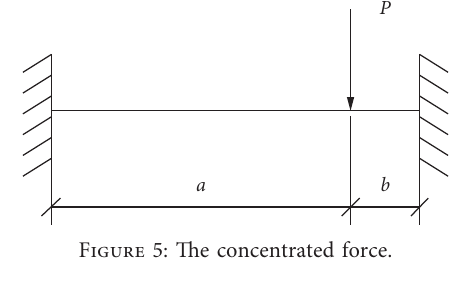
Figure 5: The concentrated